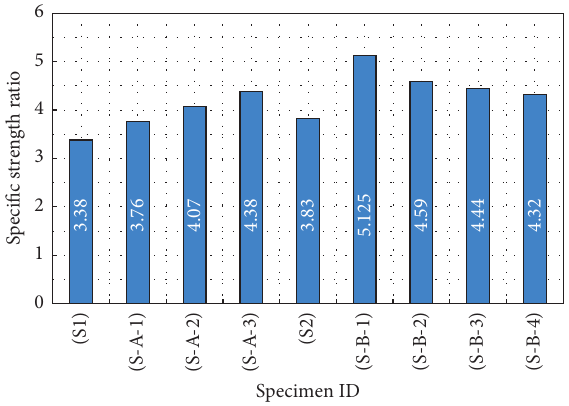
Figure 15: Specific strength ratio for all